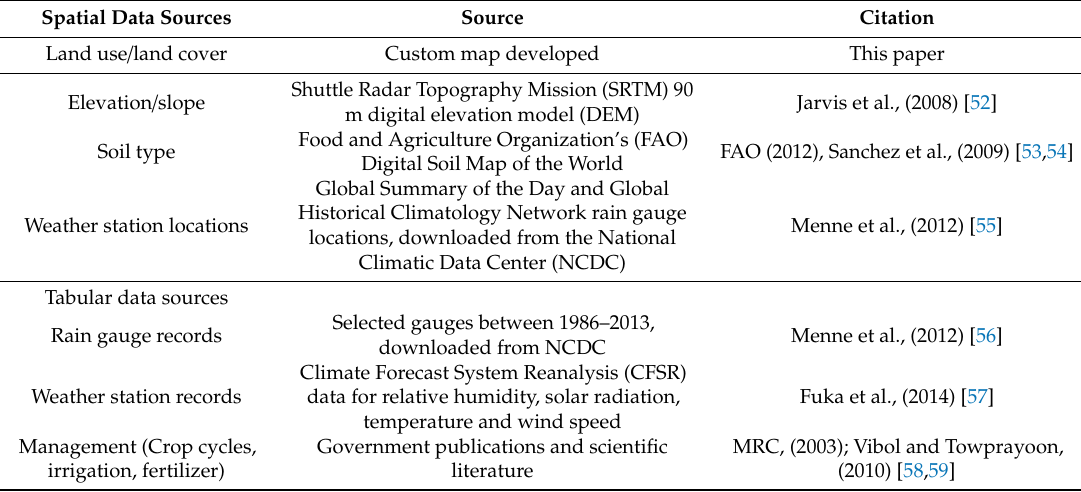
Table 1. Data sources for Soil and Water Assessment Tool model